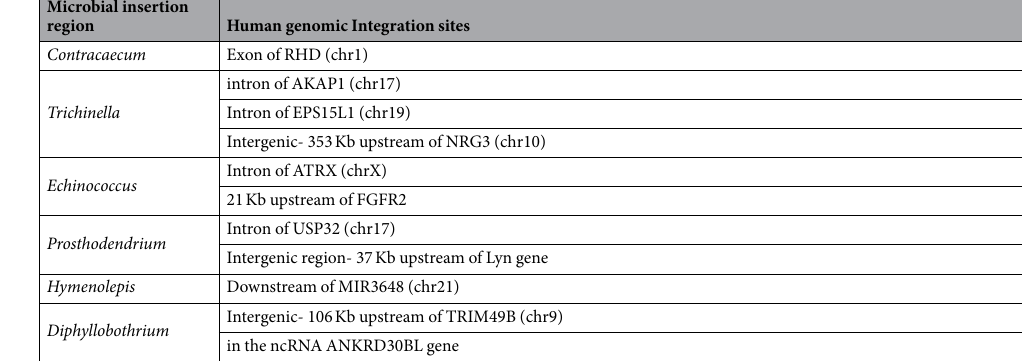
Table 2. Microbial genomic integration sites in the OCSCC host somatic